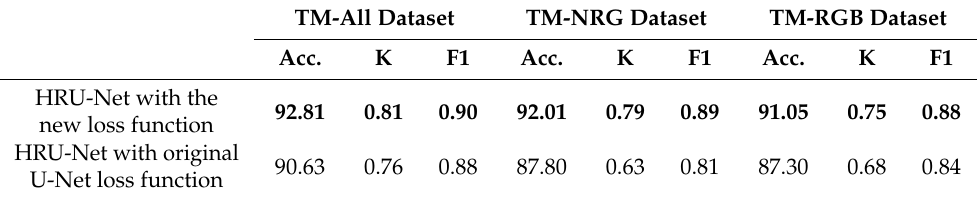
Table 8. Comparison of the HRU-Net with or without the modified loss